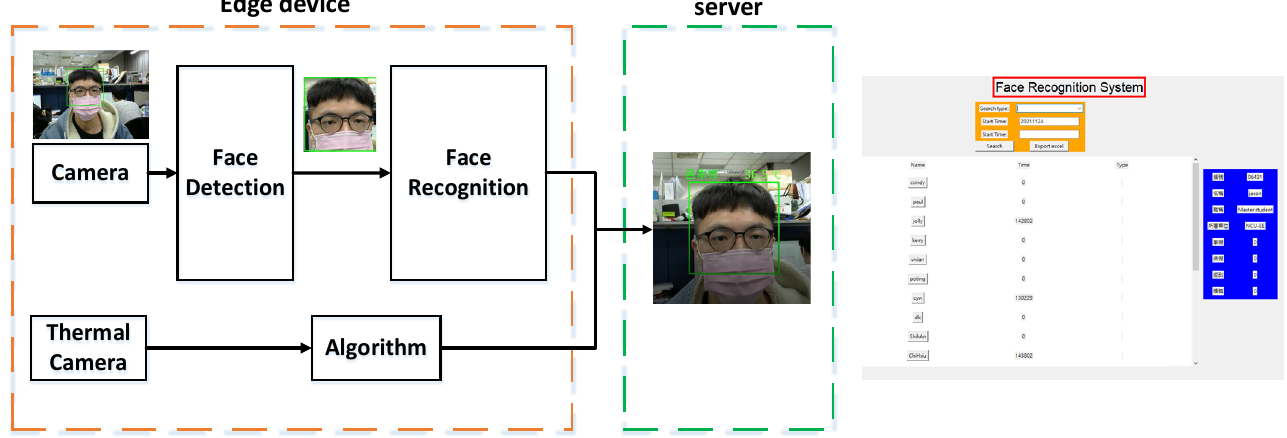
Figure 5. Architecture of masked face recognition system. With our user interface, it makes the en- tire attendance system more